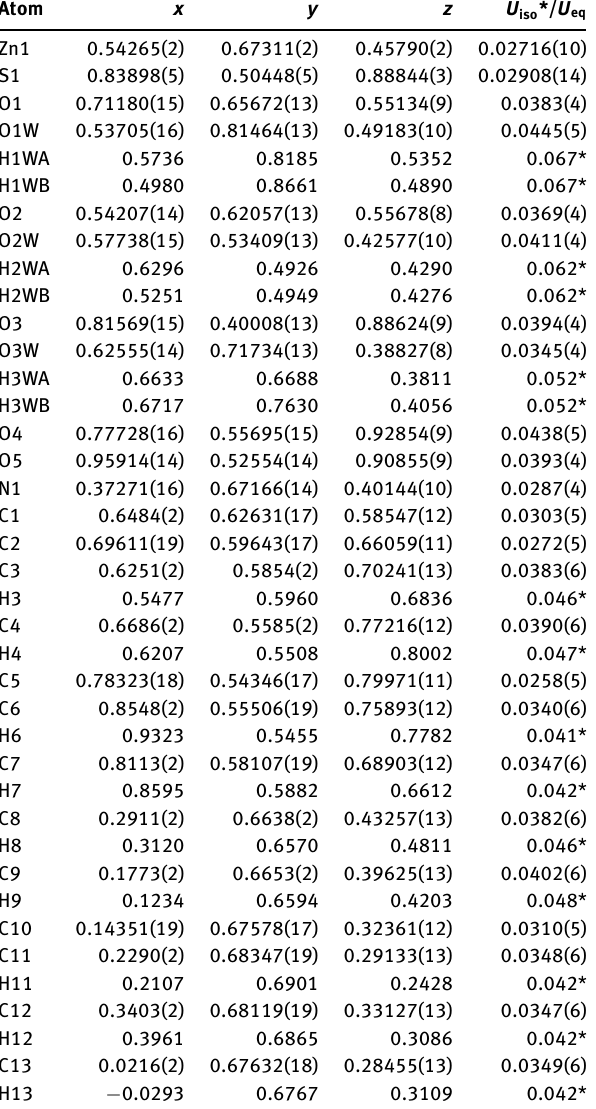
Table 2: Fractional atomic coordinates and isotropic or equivalent isotropic displacement parameters (Å 2